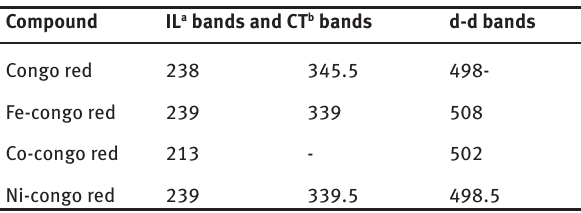
Table 1: Characteristic bands of the complexes in deionized water in UV-Vis spectra [λ , in max